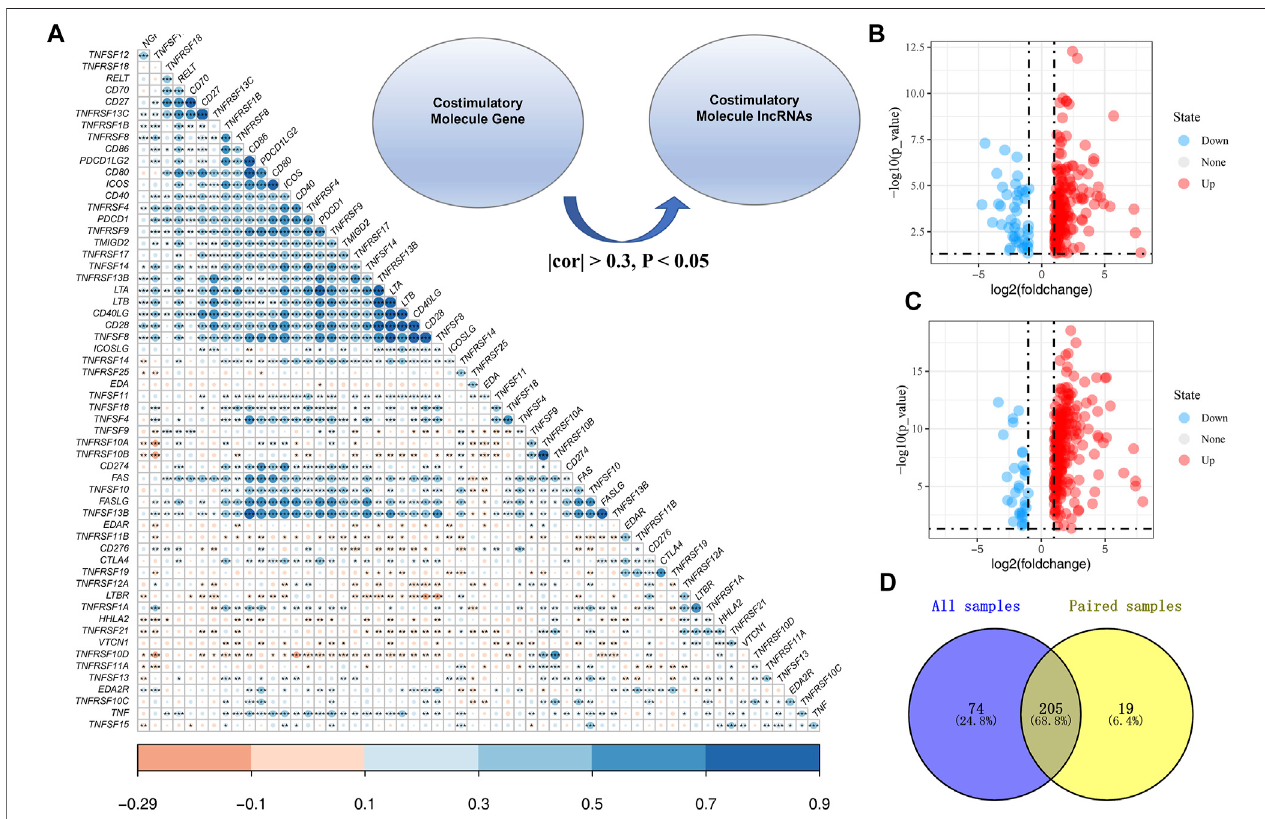
FIGURE 2 | Identi fi cation of costimulatory molecule – related lncRNAs. (A) : Overview of CMGs in the TCGA cohort; Co-expression analysis was performed to identifycostimulatorymolecule – relatedlncRNAs withthePearsoncorrelationcoef fi cient of|cor| > 0.3and p < 0.05withCMGs; (B) :Differential CMLanalysisbetweenall normalandGCtissues; (C) :DifferentialCMLanalysisbetweenpairednormalandGCtissues; (D) :Venndiagramsshowedthat205CMLsweredifferentiallyexpressedin GC samples and paired GC samples compared with normal